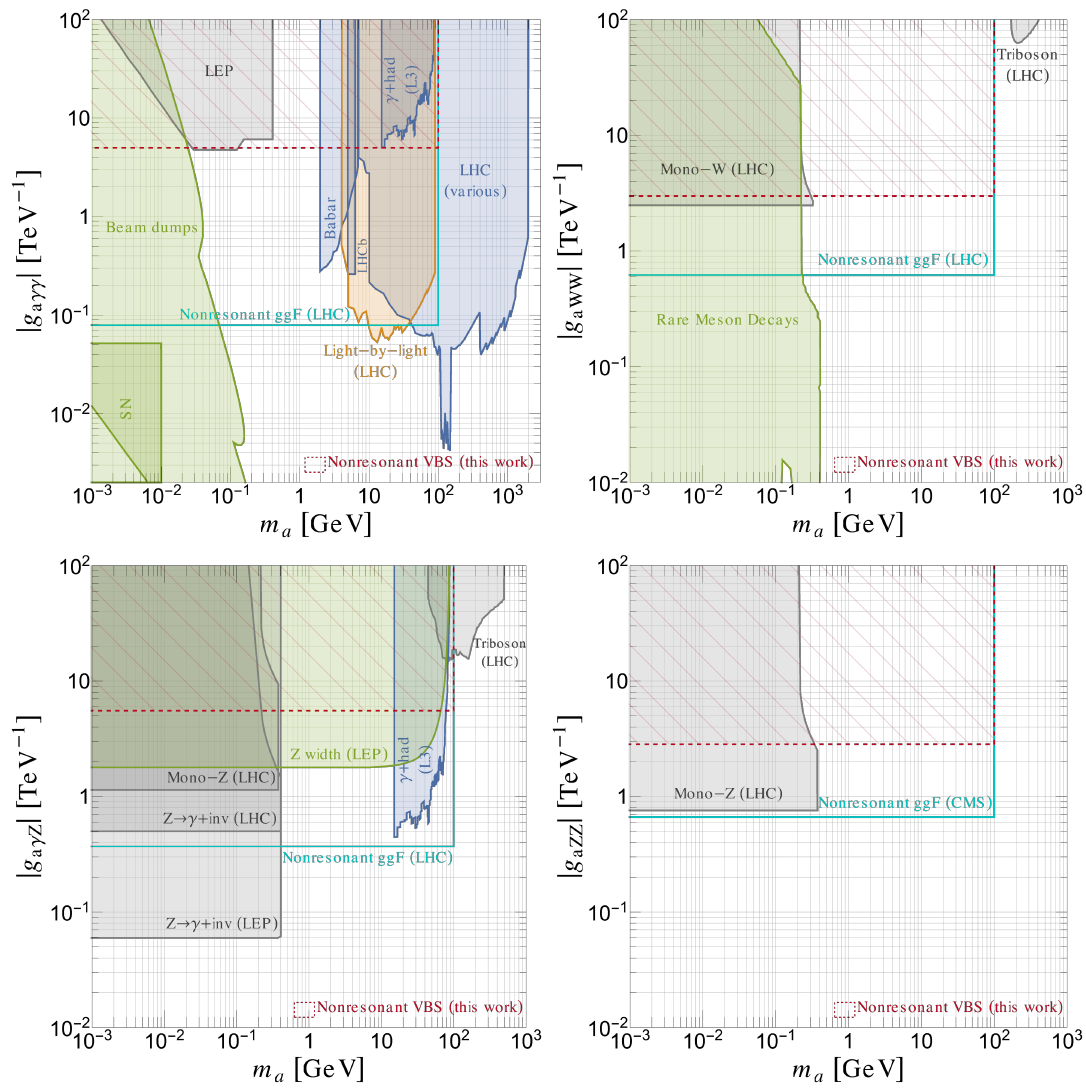
Figure 6 . Summary of current constraints on ALP couplings to EW gauge bosons defined in eq. (2.2), as a function of the ALP mass m a . Limits derived in this work are labeled “Nonresonant VBS” and shown in red . Previous constraints are shown with a color coding that indicates different underlying theory assumptions. Orange indicates a Br( a → γγ ) = 1 assumption, dark blue indicates an assumed gluon dominance g agg (cid:29) g aV , while bounds in light blue scale with 1 /g agg 1 V 2 and are given for g agg = 1 TeV − 1 . Grey indicates more complex assumptions on the ALP EW couplings. Genuine bounds, that hold without further assumptions, are in green . See the main text for more